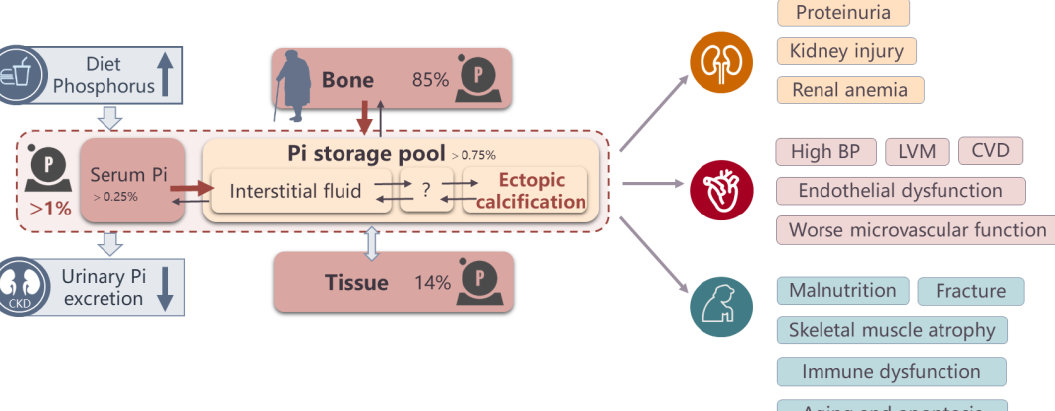
Figure 5. Reasons for phosphorus overload and harm of phosphorus overload. Note: Phosphorus balance can easily be disequilibrated by a persistent high-phosphorus diet, renal function decline, bone disease in the young population, CKD patients, and the elderly, and can finally result in phosphorus overload. Phosphorus overload leads to a serious of side effects including hyperphosphatemia, vascular calcification, a worse microvascular function, and so on. These are also the indirect evidence of phosphorus overload. The arrows mean the exchange between different tissues or organs.